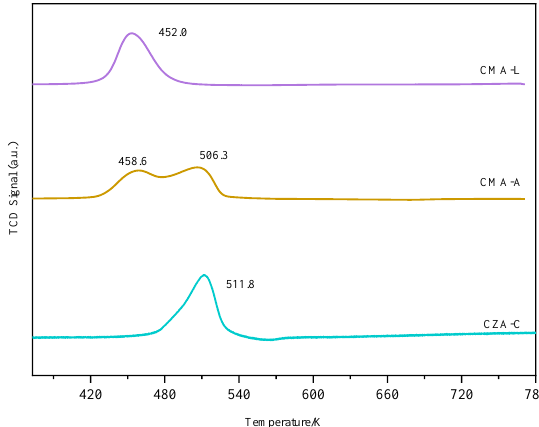
Figure 2. H 2 -TPR curves in CMA-L, CMA-A, and CZA-C after calcination.